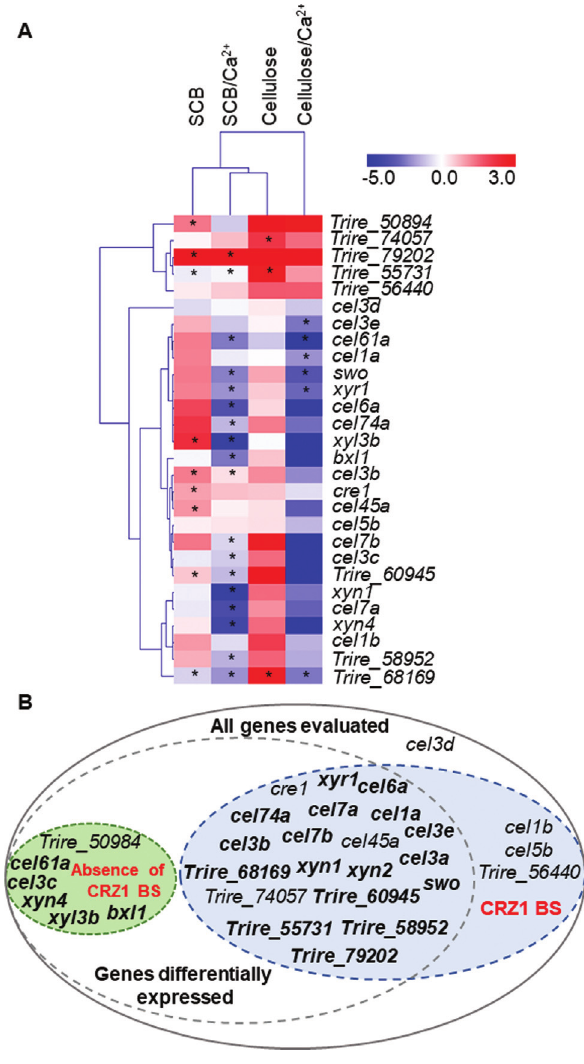
Figure 8 - (A) Heatmap of the differential expression profile of the holocellulases and calcium and transporter sugars after 8 h of induction in the presence or in the absence of 10 mM Ca 2+ . Values are representative of theexpressionobtainedwithmutant crz1 strainrelatedtotheQM6astrain. Genes presenting representative statistical significance are show with as - terisks. ID codes for calcium and sugar transporters are supported in T. reesei genome database (https://ge- nome.jgi.doe.gov/Trire2/Trire2.home.htm).(B)Representativeschemeof genes differentially expressed in the absence of CRZ1 in T. reesei and its relation to the occurrence or absence of binding sites (BS) for CRZ1 at genomic level. Bold characters represent the genes whose expression was modulated by 10 mM Ca 2+